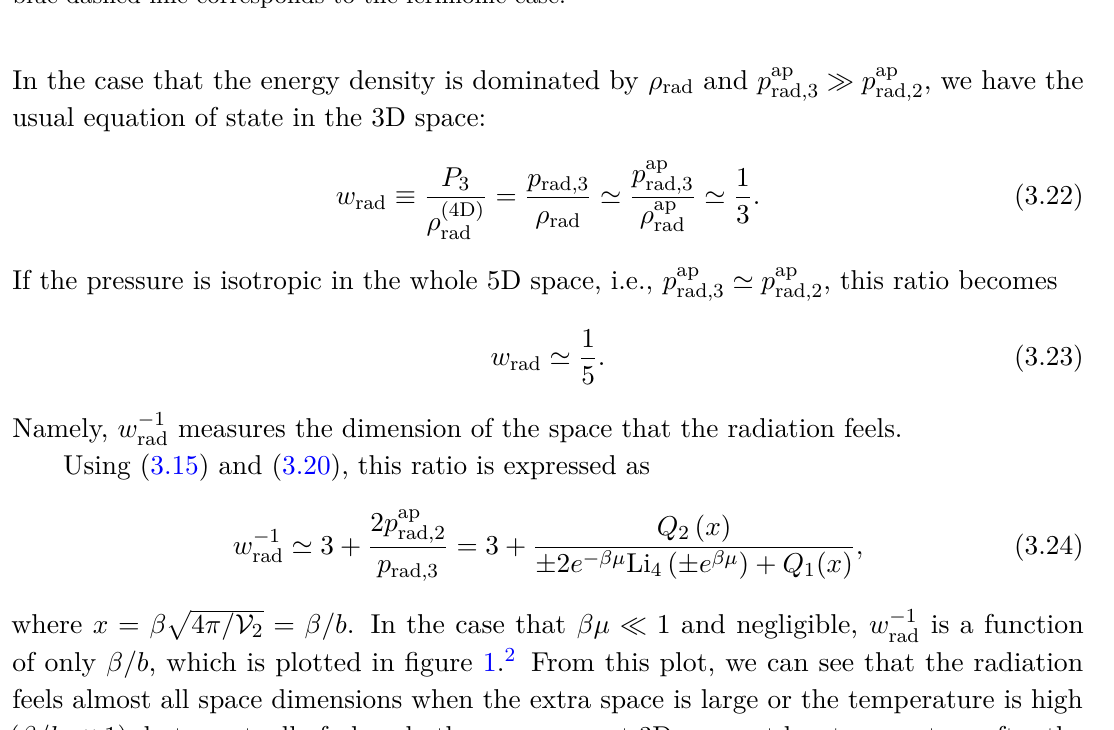
in (3.24). The red solid line corresponds to the bosonic case, while the Figure 1. The ratio w − 1 rad blue dashed line corresponds to the fermionic